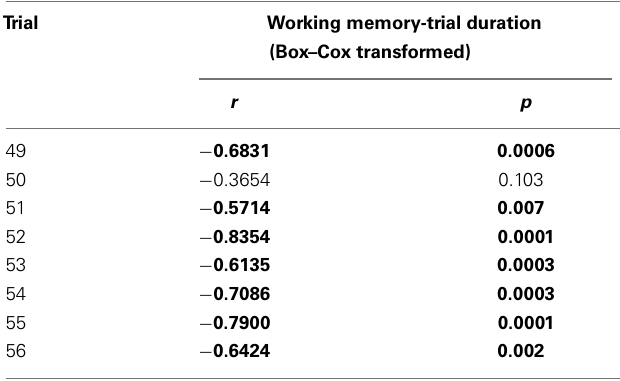
Table 4 | Pearson correlation coefficients and associated p -values for correlations between working memory and trial duration during the reversal phase (trials 49–56)